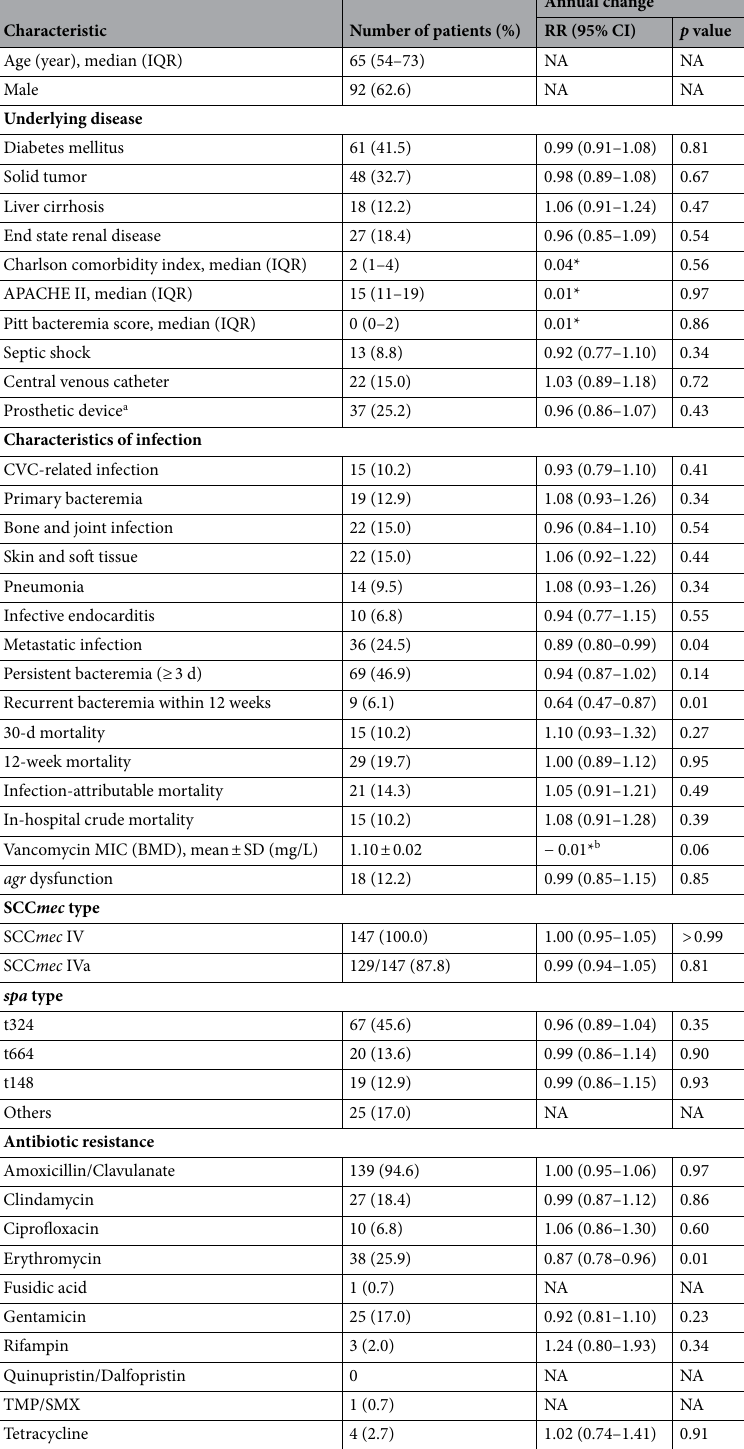
Table 3. Annual changes in the clinical and microbiological characteristics of 147 patients with community- onset infection. *A linear regression model was used for analysis. a Prosthetic device included orthopedic devices (8 patients), cardiovascular implantable electronic devices (1 patients), prosthetic valves (5 patients), and vascular grafts (24 patients) in patients with persistent bacteremia. b Result of linear regression: R 2 = 0.025, vancomycin MIC = 22.07 + (− 0.01) ×